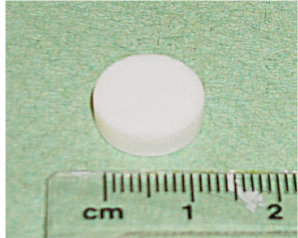
Figure 1. Freeze-dried powders were compressed to produce Bacillus Calmette–Guérin (BCG)-loaded Eudragit matrices with a diameter of 13 mm and a thickness of 2.2 mm. Eudragit matrices with a diameter of 13 mm and a thickness of 2.2